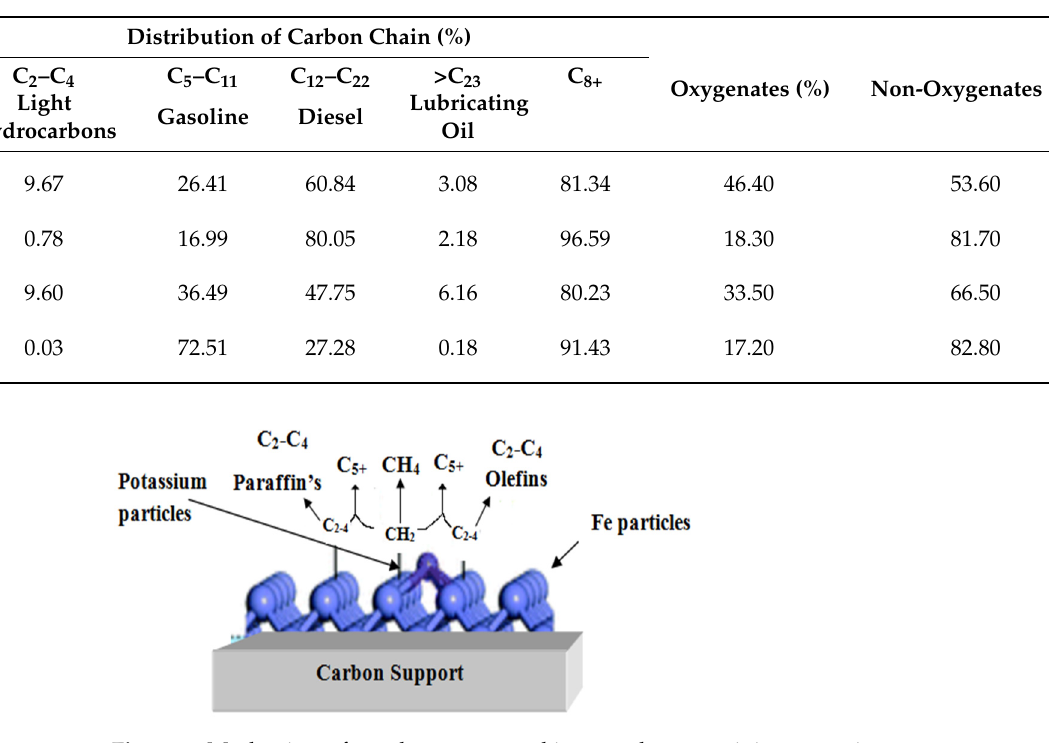
Table 3. Distribution of carbon chain with oxygenates and non-oxygenates.